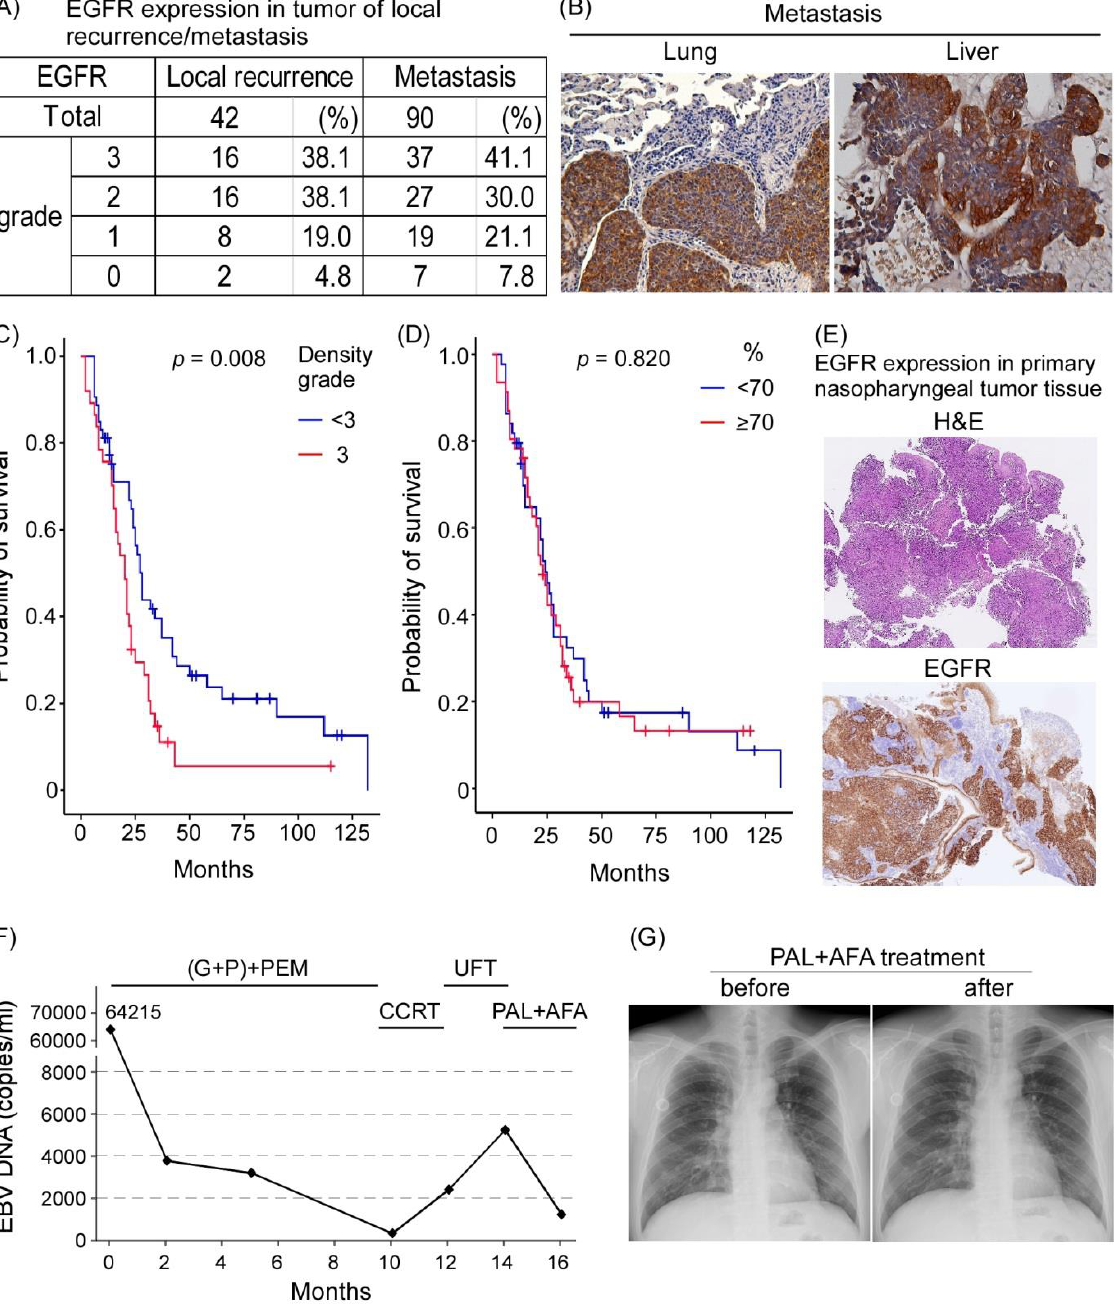
Figure 7. EGFR in patients with clinical local recurrence of NPC or metastatic NPC. ( A ) EGFR expression in patients with local recurrence and distant metastasis. ( B ) IHC staining of EGFR in local recurrence and distant metastasis tumors. ( C ) Probability of patient survival between EGFR expression density grade <3 vs 3 showed statistical significance ( p = 0.008); and ( D ) probability of survival between EGFR expression percentage grade <3 vs 3 had no statistical significance ( p = 0.82). ( E ) EGFR expression in the primary tumors of patients with NPC who received salvage therapy. (200×) ( F ) Plasma EBV DNA load reflecting that the clinical treatment response of the patient was decreased after PAL + AFA treatment. ( G ) Chest X-ray exam before and after PAL + AFA treatment at 2-month intervals revealed stable disease status.